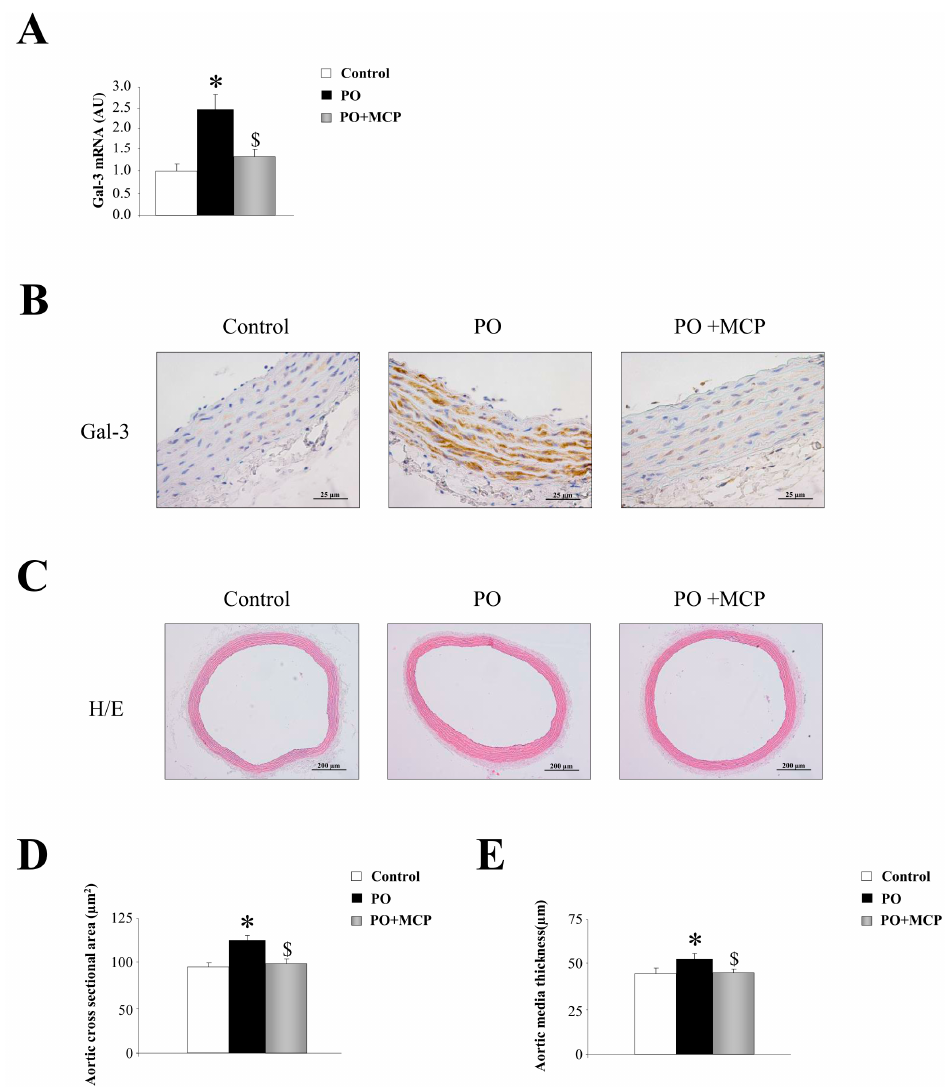
Figure 1. Pharmacological inhibition of Galectin-3 (Gal-3) decreases aortic wall thickness. Quantification of aortic Gal-3 mRNA levels in controls, pressure overload (PO) and PO + modified citrus pectin (MCP) rats ( A ); representative pictures of aortic sections immunostained for Gal-3 ( B ); haematoxylin/eosin staining of aortas ( C ); and quantification of aortic morphometry ( D , E ). Histogram bars represent the mean ± standard error of mean (SEM) of each group of rats in arbitrary units normalized to hypoxanthine phosphoribosyltransferase (HPRT) and β -actin for cDNA. Magnification 40×. (Control rats, n = 7; Pressure Overload rats, PO, n = 7; and Pressure Overload rats treated with MCP, PO + MCP, n = 7). * p < 0.05 vs. control group; $ p < 0.05 vs. PO group.